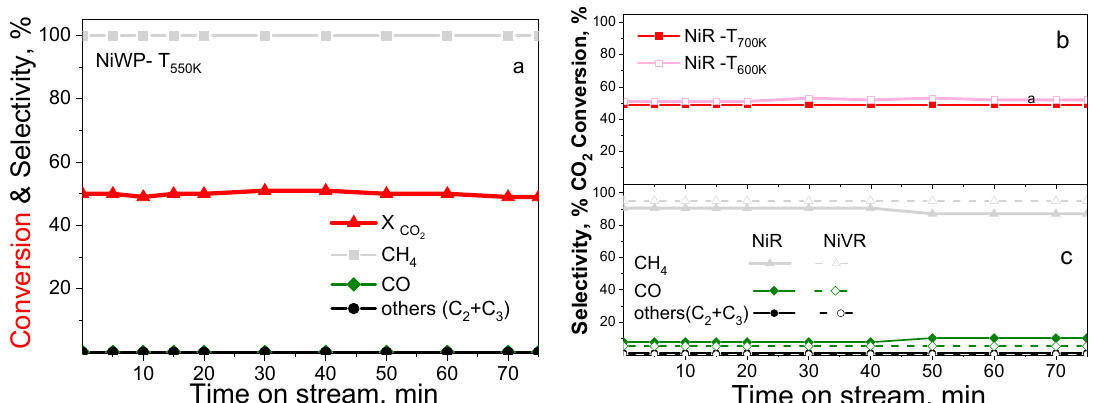
Figure 7. Stability test and selectivity to CH 4 , CO, and other C 2 –C 3 products at 50% CO 2 conversion in the function of time-on-stream up to 72 h for (a) NiWP, (b, c) NiR, and NiVR catalysts (temperature, where 50% CO 2 conversion was attained for each catalyst, is displayed in the panels).